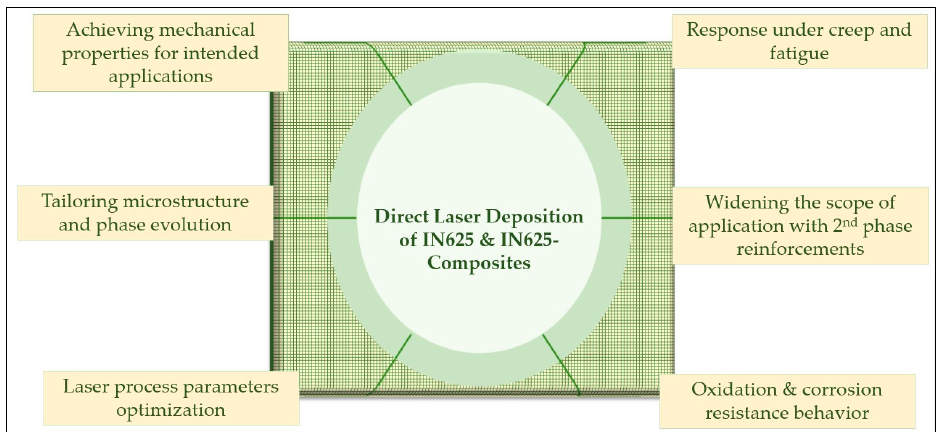
Figure 2. Key areas addressed in the article.